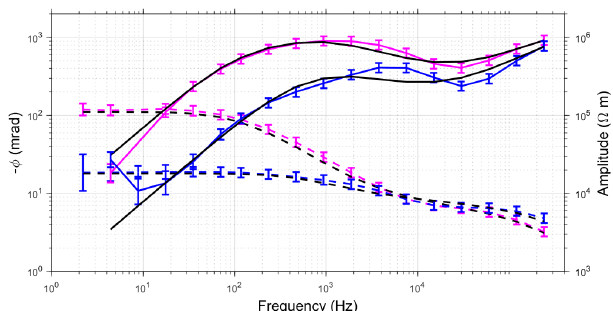
Figure 11. Data fit of the 2-D inversion for two stations of the Lake Prestvannet profile. The blue lines correspond to a measurement at 11 . 5m, which is on the lake, the red lines to an onshore measure- ment at 28m, with the corresponding inverted spectra (black). Both were measured with a Wenner configuration ( a = 1 . 5m). The mea- sured data are the same as in Fig. 5. The amplitude is indicated by the dashed lines and the phase shift by the solid